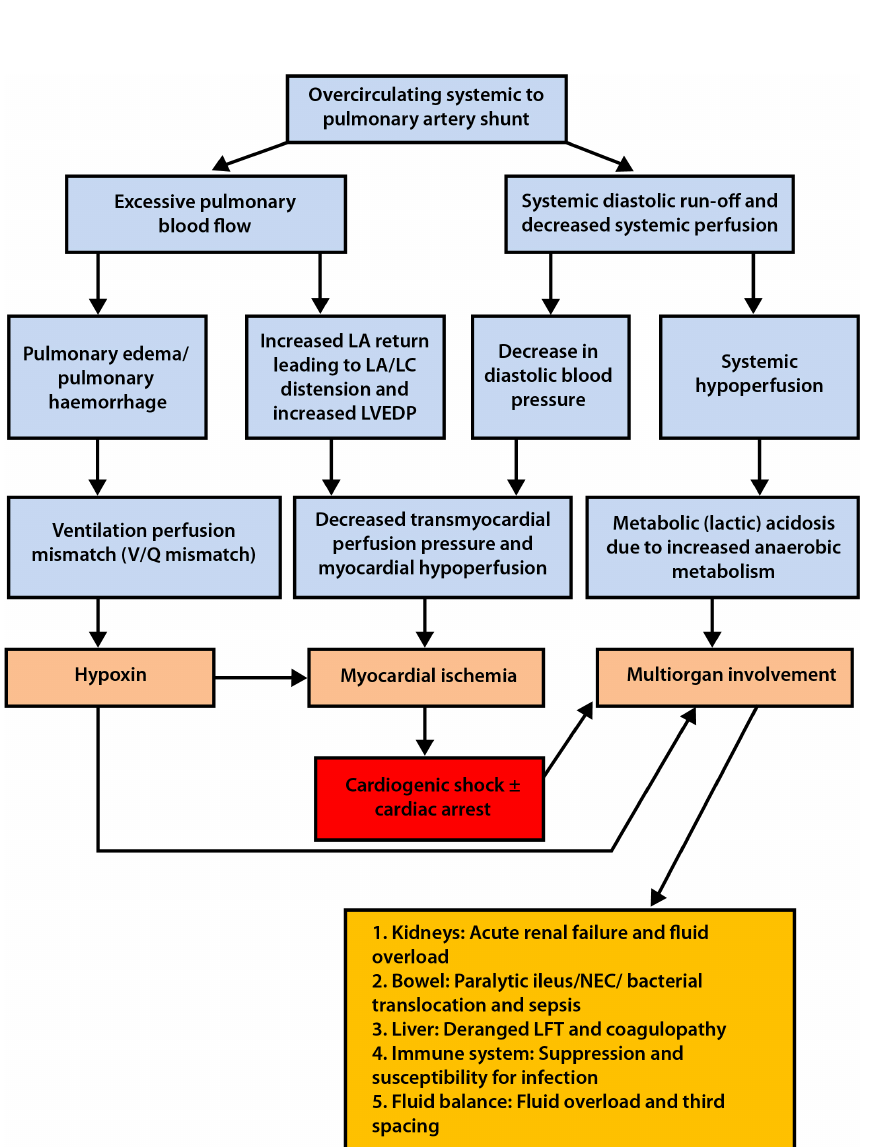
Fig. 4 - Pathophysiology of systemic to pulmonary artery shunt with excessive pulmonary blood flow. LA=left atrial; LFT=liver function test; LV=left ventricular; LVEDP=left ventricular end-diastolic pressure; NEC=necrotizing